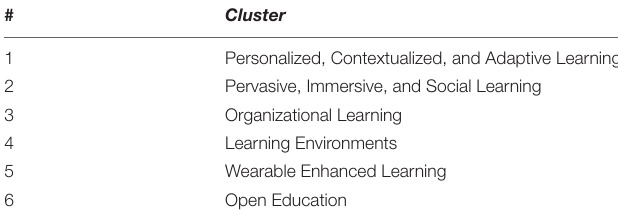
TABLE 2 | Clusters of topics from the thematic workshops and keynotes.